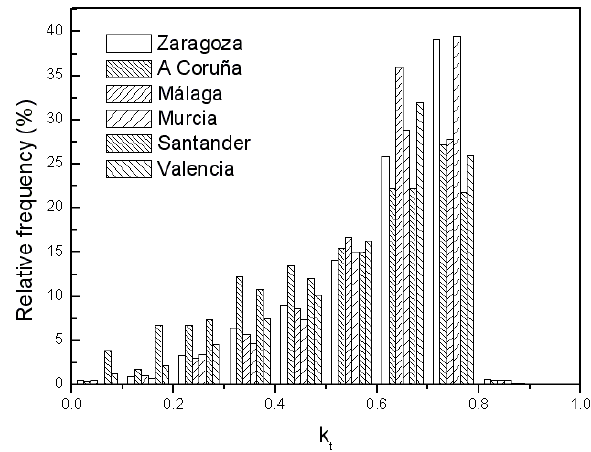
Fig. 1. Histograms of the global broadband hemispherical transmit- Figure 1: Histograms of the global broadband hemispherical transmittance (k t ) at each tance ( k t ) at each location for the study location for the study period.